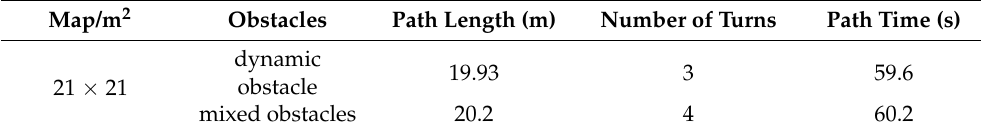
Table 3. Comparison of algorithm performance in different maps.